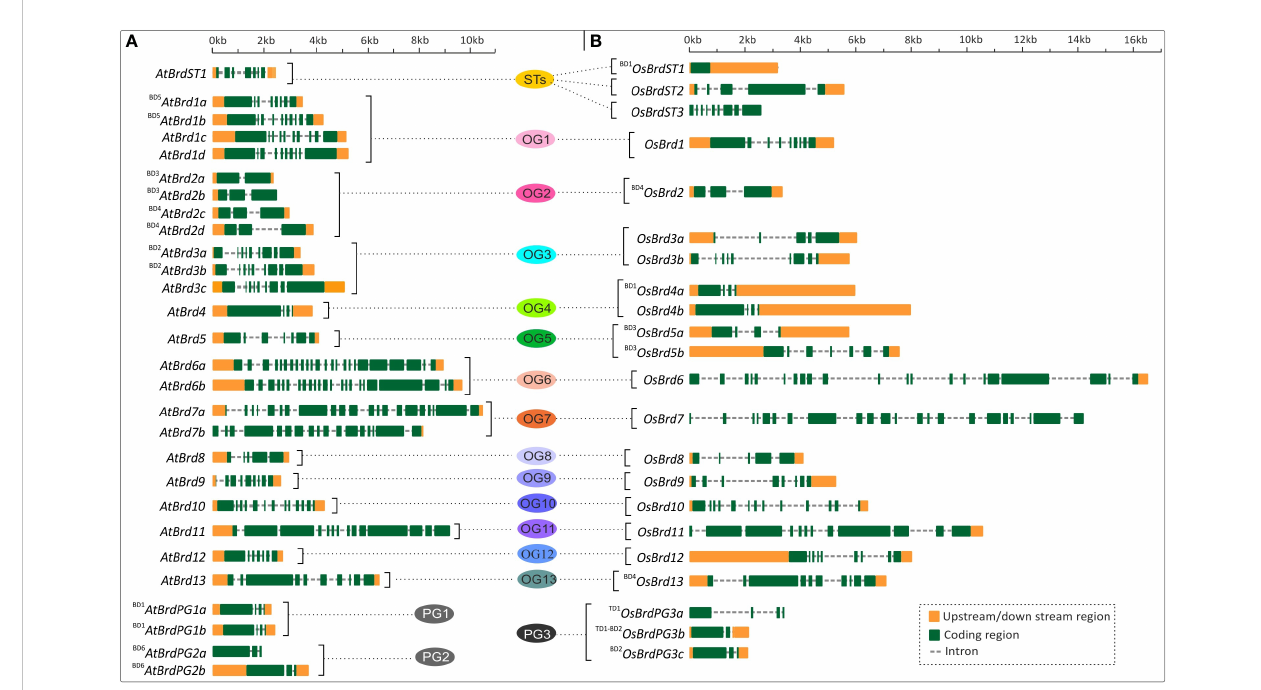
FIGURE 2 Comparison of gene structure and organization of Brd -genes from A. thaliana (A) and O. sativa (B) , belonging to thirteen ortholog groups (OG1-13), three paralog groups (PG1-3), and singleton category (STs). The BRD-members speci fi c to each group are arranged side-by-side for comparison, and the designations ‘ BD ’ and ‘ TD ’ in the names indicate the block or tandem duplication. Different regions of genes are indicated by color codes (orange: upstream/downstream region including UTR, green: exons, and dashed line: intron). Scale on the top indicates the length in kilobase